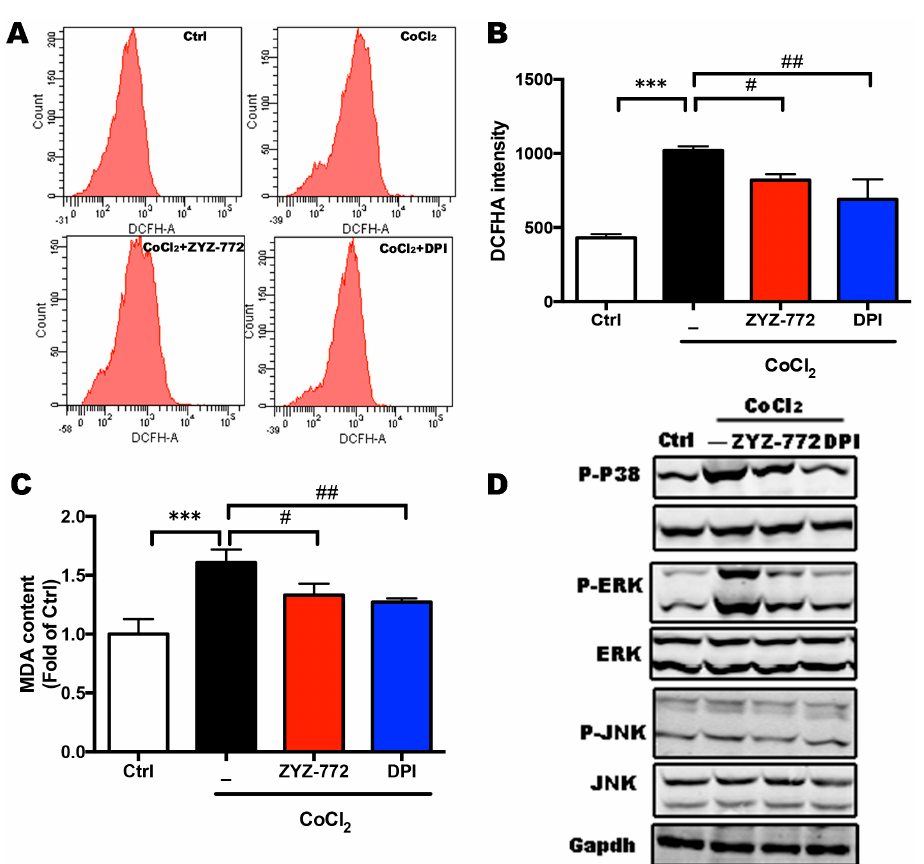
Figure 3. ZYZ-772 mitigated CoCl 2 induced ROS generation and activation of MAPK signaling